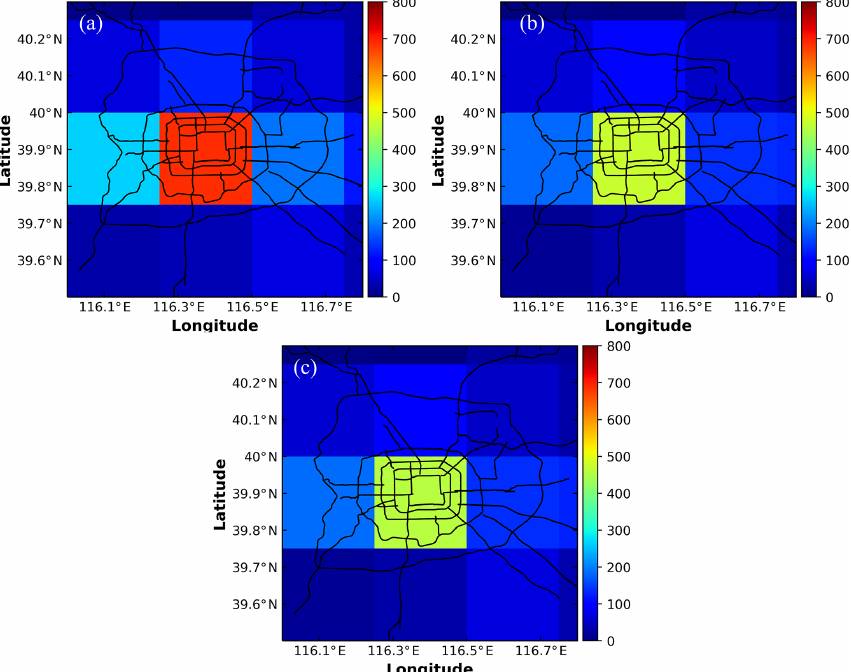
Figure 10. Spatial distributions of monthly averaged NO x emission rate (molkm − 2 h − 1 ) over Beijing based on the MEIC inventory in (a) January, (b) September, and (c) October in 2012.